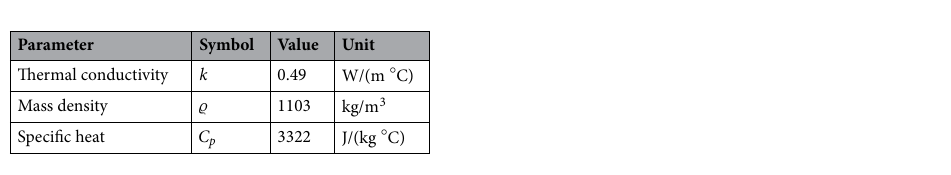
Table 1. Thermal properties of muscle tissue used in phantom heat transfer